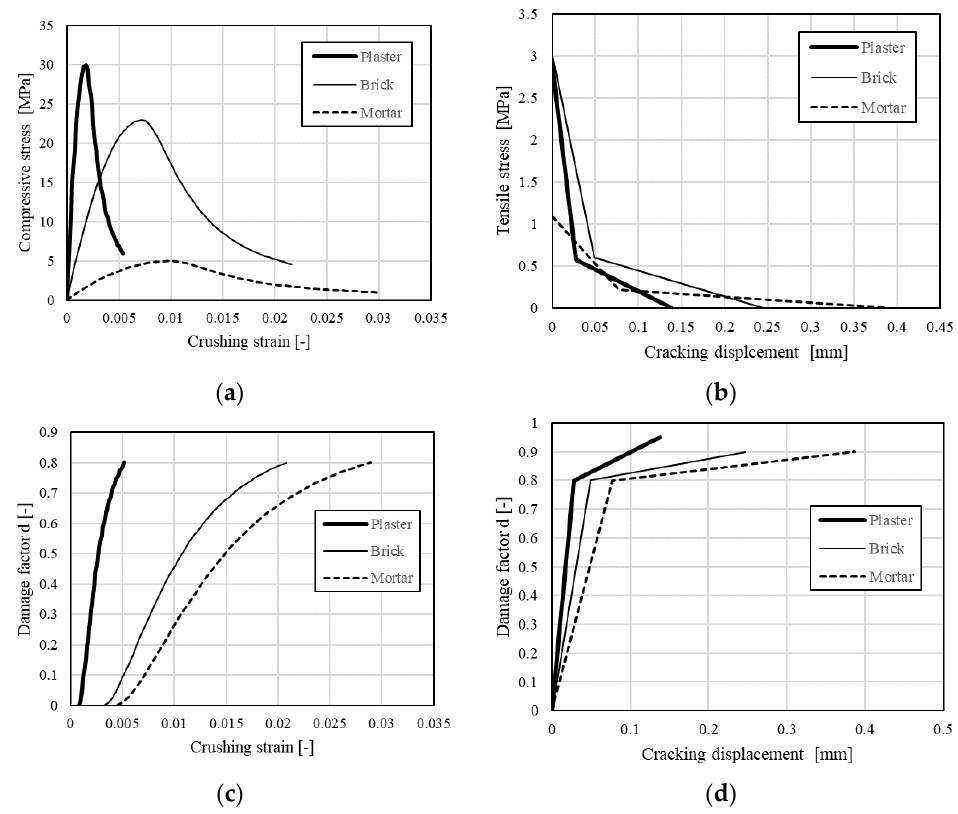
Figure 7. Constitutive behavior of plaster, brick, and mortar: ( a ) stress–strain of compression; ( b ) post-failure stress–displacement of tension; ( c ) damage factor of compression; ( d ) damage factor of tension. Table 2. CDP parameters for brick, mortar and